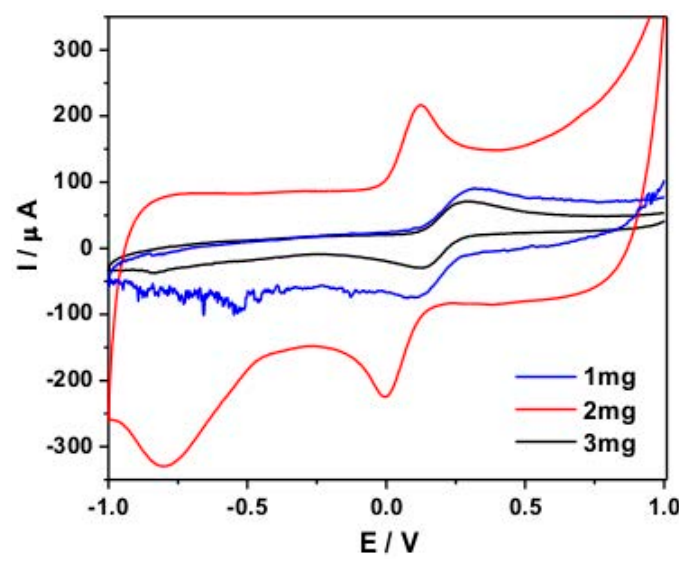
Figure 8. Cyclic voltammetry of DGP modified electrodes of different concentrations.